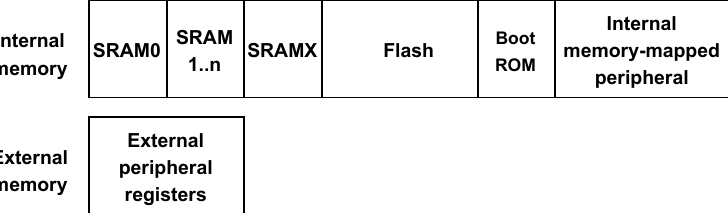
Figure 7. Memory on chip of a Prover